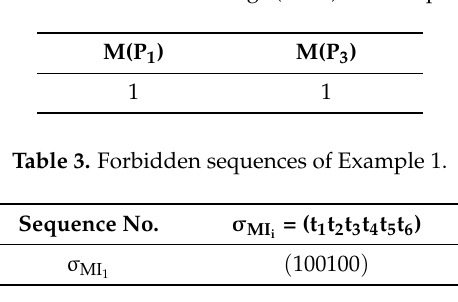
Table 2. Forbidden markings (P1P3) of Example 1.